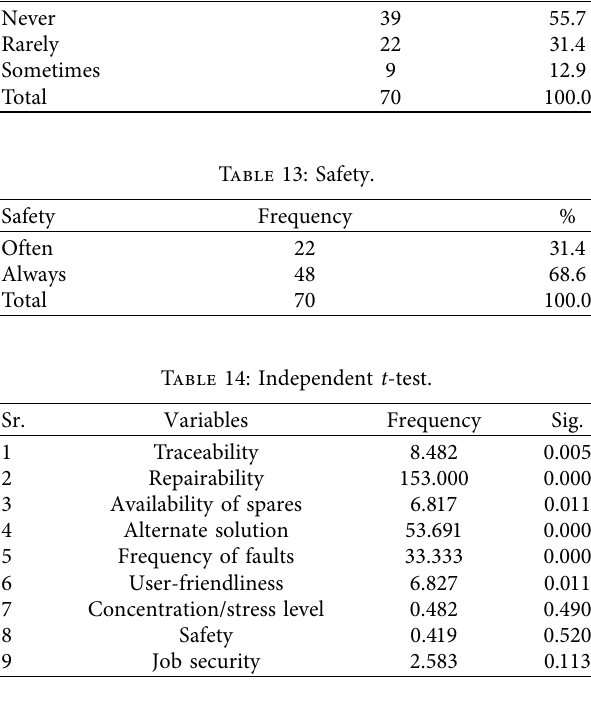
Table 22: User-friendliness.